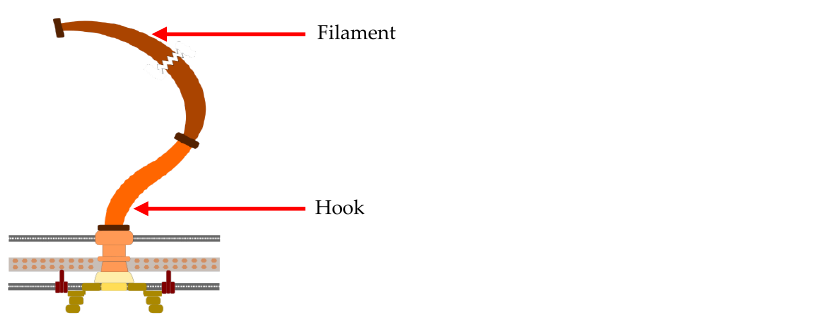
Figure 1. Placement of rotary motor, hook, and flagellum or filament.